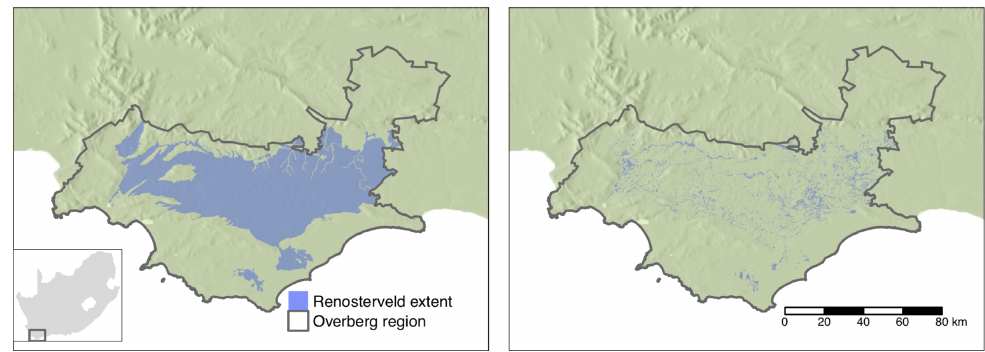
Figure 2. The natural extent of lowlands Renosterveld in study region ( left panel ) and the remaining natural and degraded fragments ( right panel